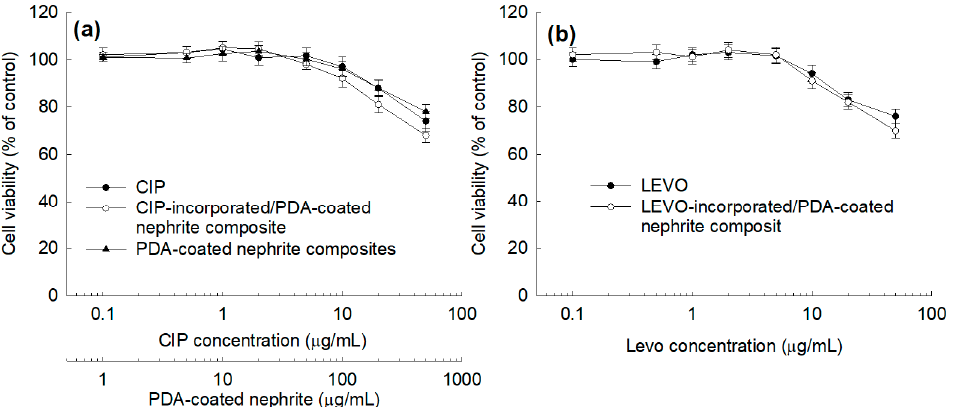
Figure 8. Cell cytotoxicity of CIP- or LEVO-incorporated/PDA-coated nephrite composites (CIP (or LEVO)/dopamine/nephrite ratio = 0.2/1.0/1.0) against ARPE-19 human retinal pigmented epithelial cells. ( a ) The effect of free CIP, CIP-incorporated/PDA-coated nephrite composites and PDA-coated nephrite composites; ( b ) The effect of free LEVO or LEVO-incorporated/PDA-coated nephrite composites. Overall, 2 × 10 4 ARPE-19 cells in 96-well plates were treated with each compound for 24 h. Cell viability was evaluated with an MTT assay.